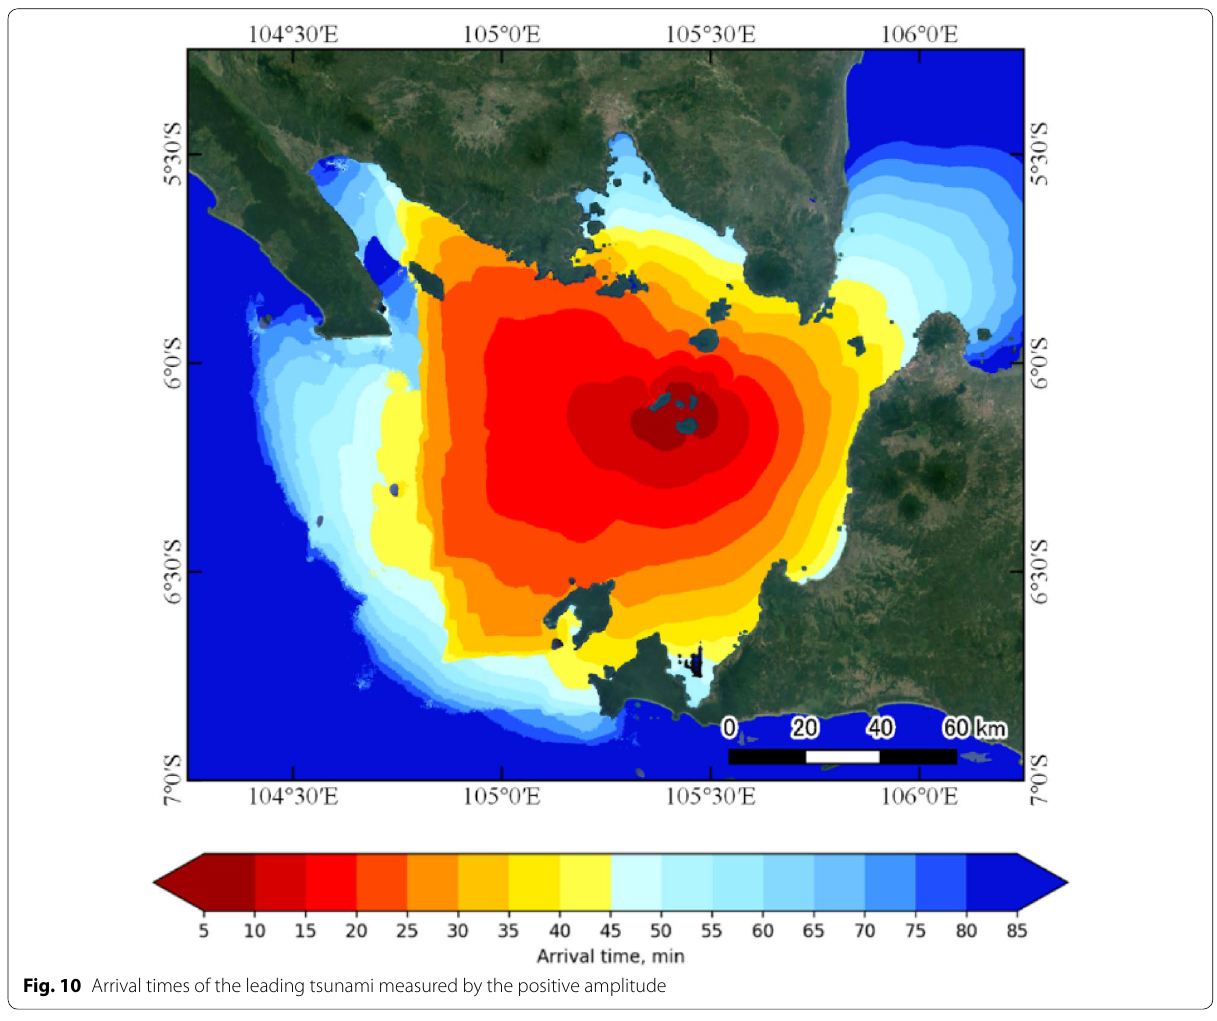
Fig. 10 Arrival times of the leading tsunami measured by the positive